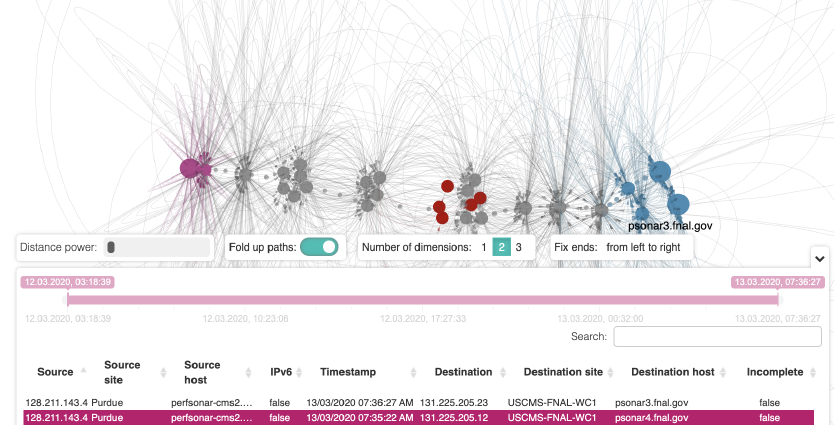
Figure 4: Visualisation of multiple network paths as measured by the traceroute tool between Purdue and Fermi National Accelerator